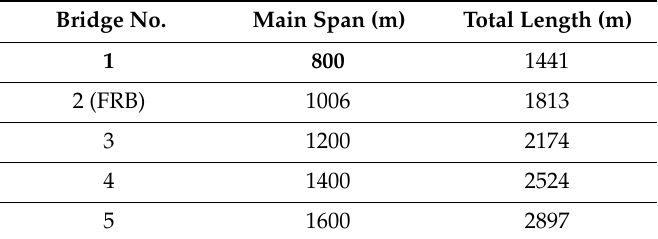
Table 2. Notional bridges lengths.